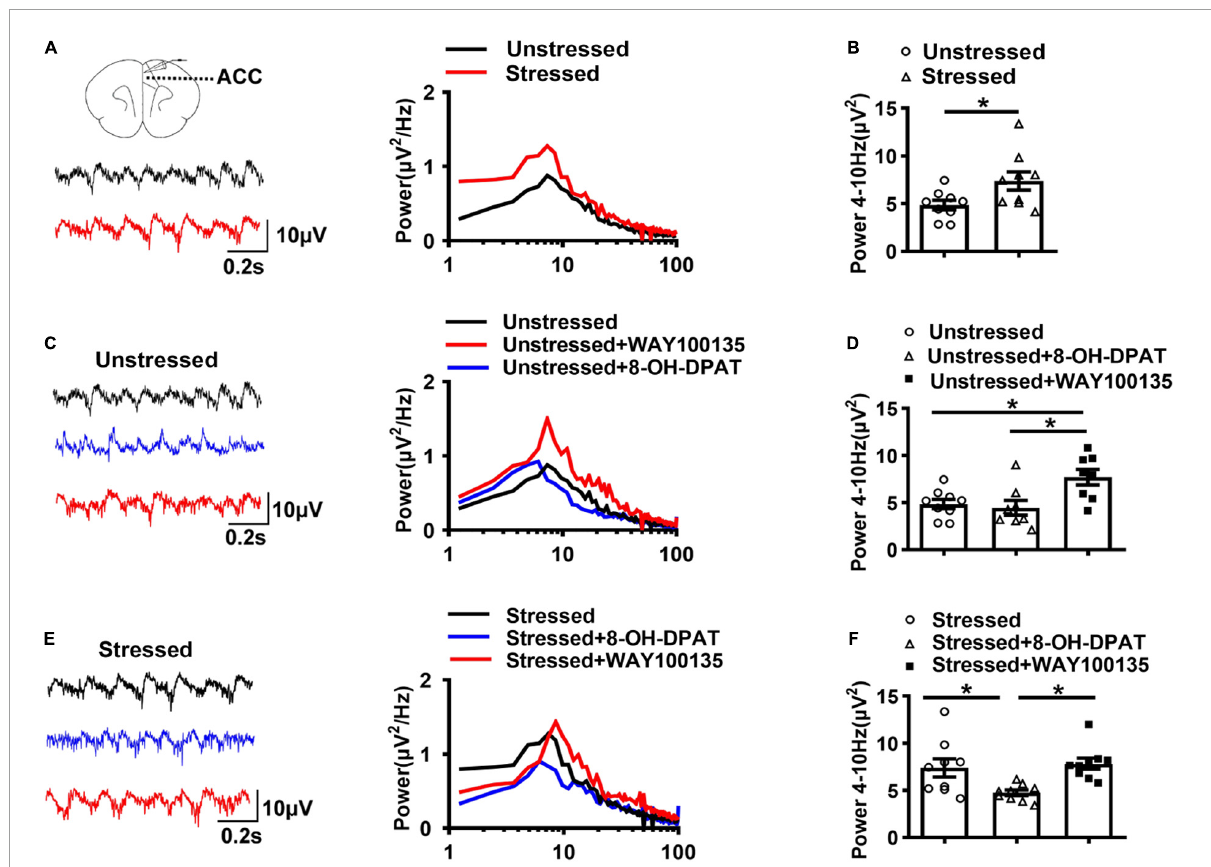
FIGURE3 5-HT 1A Rs regulated theta oscillations (4–10 Hz) in ACC of stressed rats. (A) Sample traces (left) and power spectra (right) of oscillations induced by 50 µ M carbachol (CCh) and 0.8 µ M kainic acid (KA) in ACC slices of unstressed (black line) and stressed (red line) rats. (B) The integral power of theta oscillations in ACC (Unstressed: n = 9 from seven rats, Stressed: n = 9 from five rats). (C) Sample traces (left) and power spectra (right) of oscillations in ACC slices of unstressed rats in the presence of 8-OH-DPAT (20 µ M) or WAY100135 (10 µ M). (D) Summary of the data showing the effect of 8-OH-DPAT and WAY100135 on theta oscillations in ACC of unstressed slices (Unstressed: n = 9 from six rats, Unstressed + 8-OH-DPAT: n = 8 from six rats, Unstressed + WAY100135: n = 8 from five rats). (E) Sample traces (left) and power spectra (right) of oscillations in ACC slices of stressed rats in the presence of 8-OH-DPAT (20 µ M) or WAY100135 (10 µ M). (F) Summary of the data showing the effect of 8-OH-DPAT and WAY100135 on theta oscillations in ACC of stressed slices (Stressed: n = 9 from five rats; Stressed + 8-OH-DPAT: n = 9 from six rats; Stressed + WAY100135: n = 9 from six rats). * p < 0.05. Data are presented as means ±